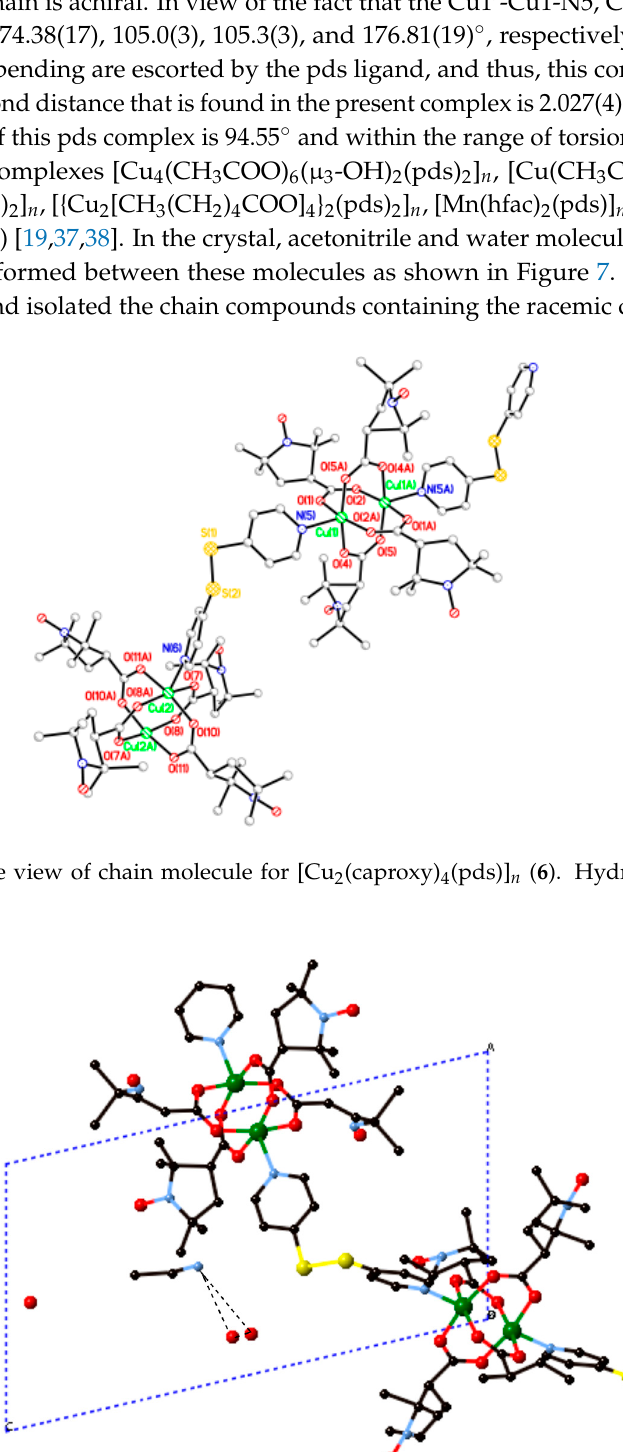
Figure 7. Packing diagram of [Cu 2 (caproxy) 4 (pds)] n ( 6 ). Hydrogen atoms are omitted for clarity. Dotted lines denote the hydrogen bondings.